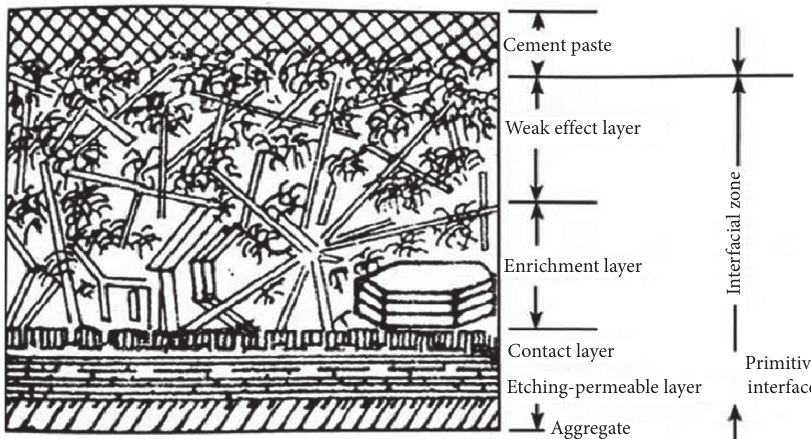
Figure 7: Songshan Jie’s model.